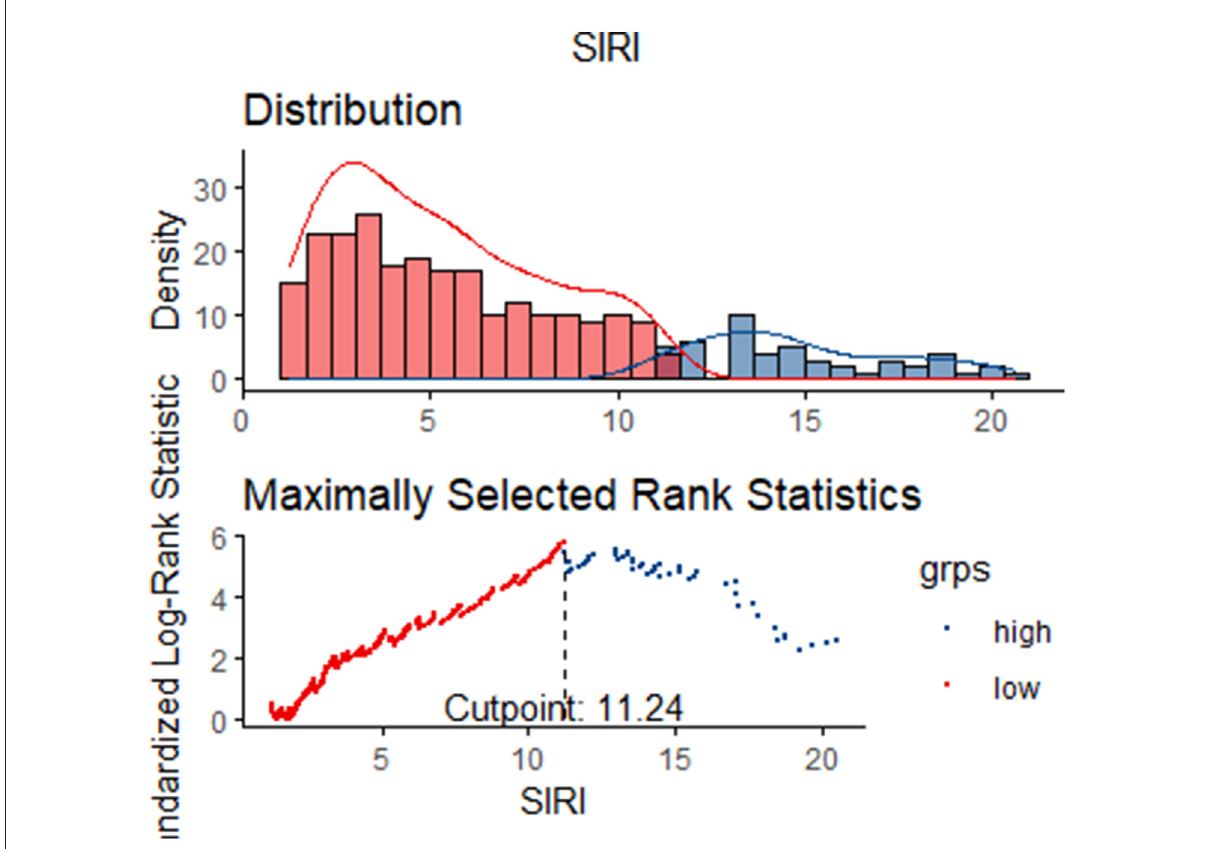
FIGURE2 The optimal cutoff value of